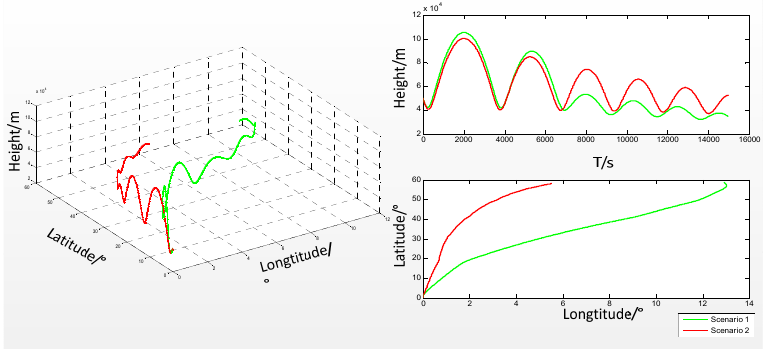
Figure 1. Hypersonic glide vehicle (HGV) maneuvering trajectory.